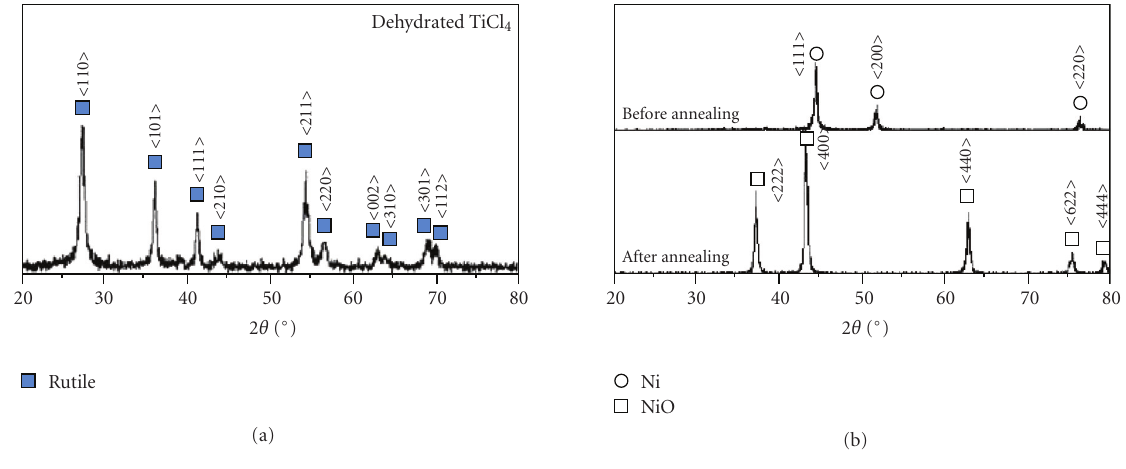
Figure 2: XRD patterns of Ni, NiO, and dehydrated TiCl 4